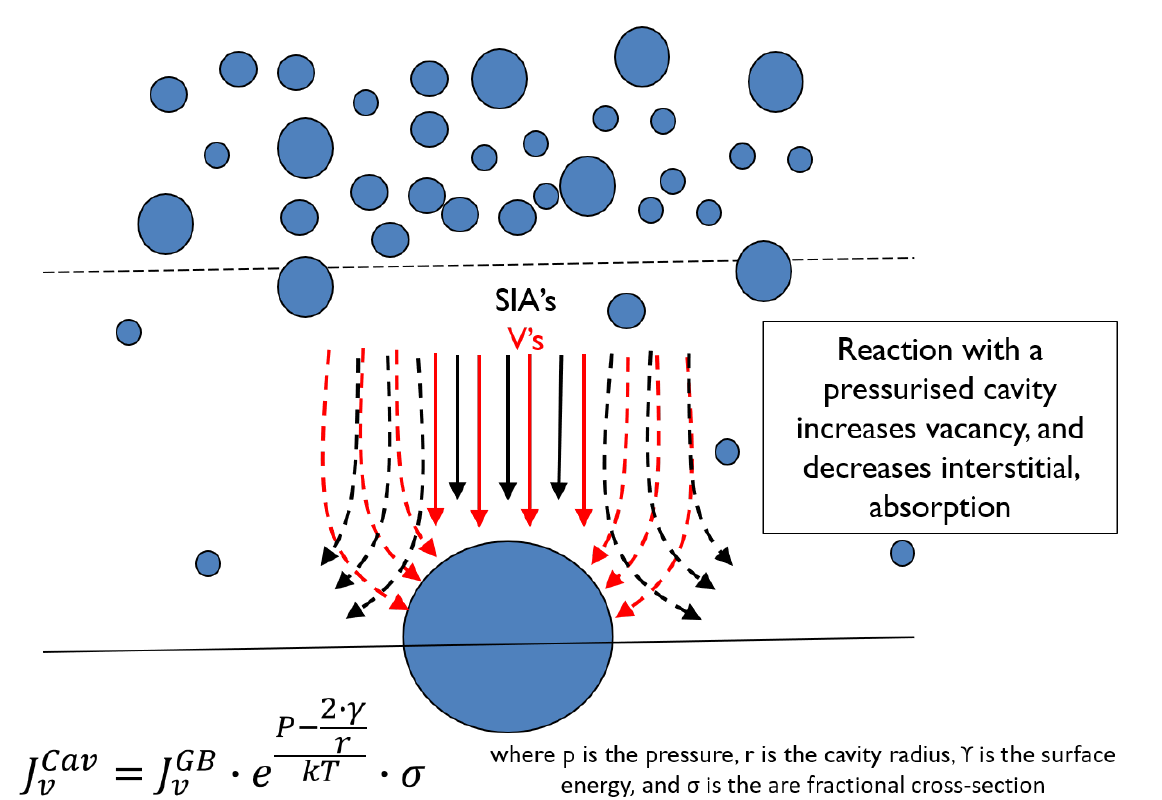
Figure 14. Schematic diagram illustrating source of vacancy (red) and interstitial (black) point defect fluxes to grain boundaries. There is a higher vacancy, relative to interstitial, flux from the grain interior. The flux to cavities is a function of the point defect flux to the boundary and an interaction term. p is the pressure, r is the cavity radius, γ is the surface energy, and σ is the area fractional cross-section.